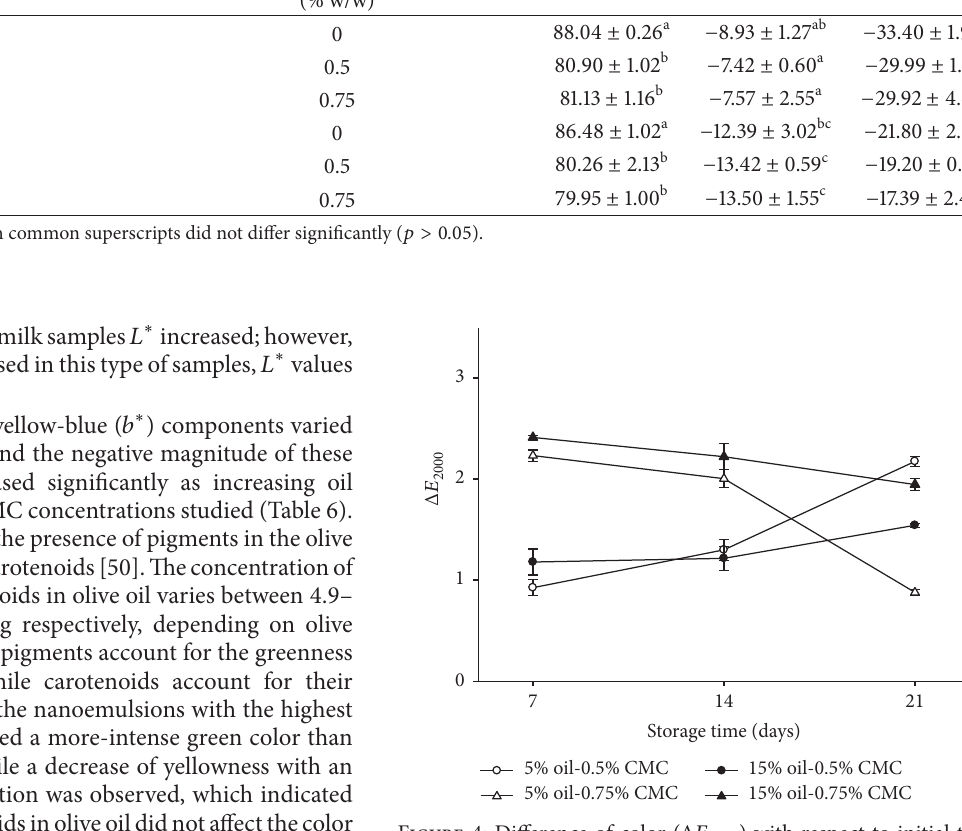
Figure 4: Difference of color ( Δ𝐸 2000 ) with respect to initial time (day 0) of storage at 5 ∘ C of different O/W nanoemulsions (5% oil: empty symbols, 15% oil: filled symbols, 0.5% CMC: circle, and 0.75% CMC: